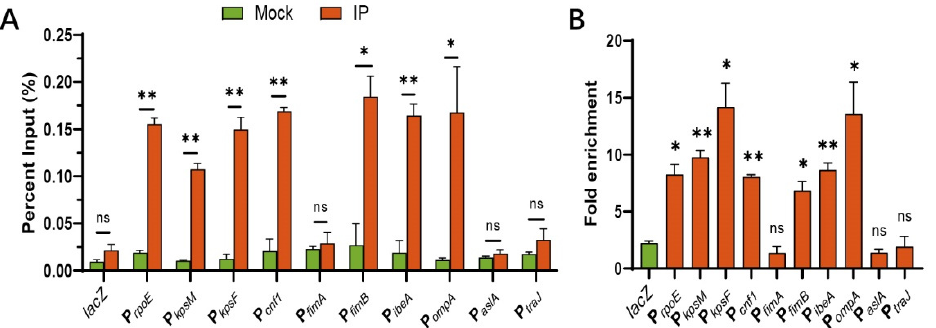
Figure 4. Virulence factors are directly regulated by RpoE in vivo. ( A ) Percent input of the promoter region of virulence factors in RpoE-ChIP samples. ( B ) Fold enrichment of the promoter region of virulence factors in RpoE-ChIP samples. * p < 0.05; ** p < 0.01; ns, not significant by Student’s t -test.